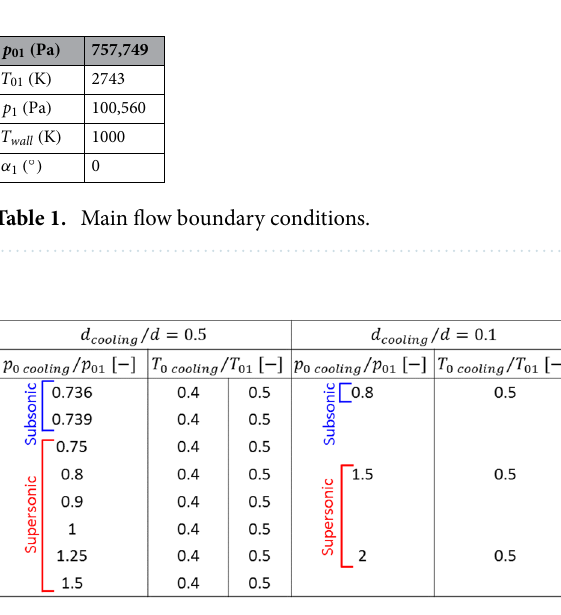
Table 2. Cooling injection boundary conditions and